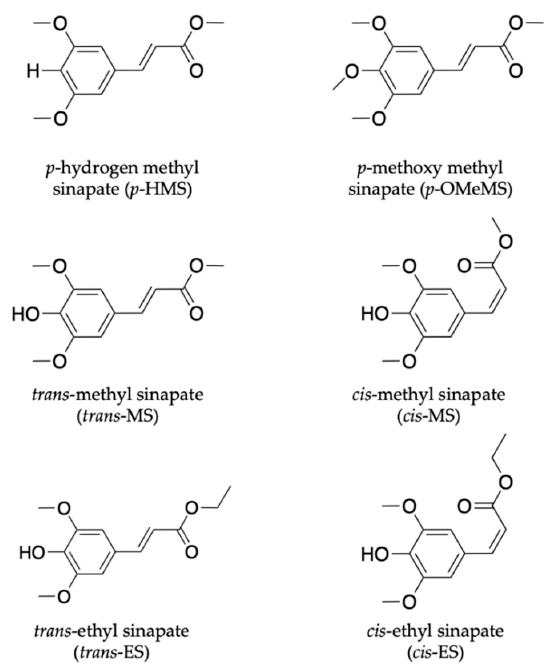
Figure 6. Chemical structures of sinapate ester derivatives including p -hydrogen methyl sinapate ( p -HMS), p -methoxy methyl sinapate ( p -OMEMS), trans -methyl sinapate ( trans -MS) and cis -methyl sinapate ( cis -MS) studied by Zhao et al. [111,113]. Also shown are trans -ethyl sinapate ( trans -ES) and cis -ethyl sinapate ( cis -ES) studied by Horbury et al. [114] .